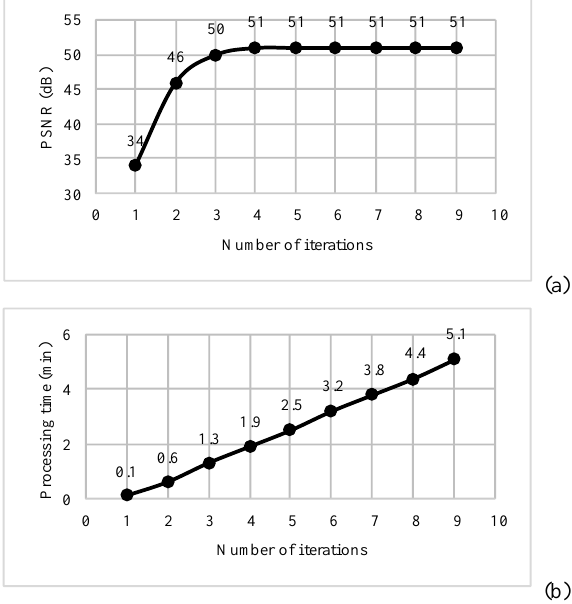
Figure 4 . The effect of the number of iterations on (a) PSNR and (b) processing